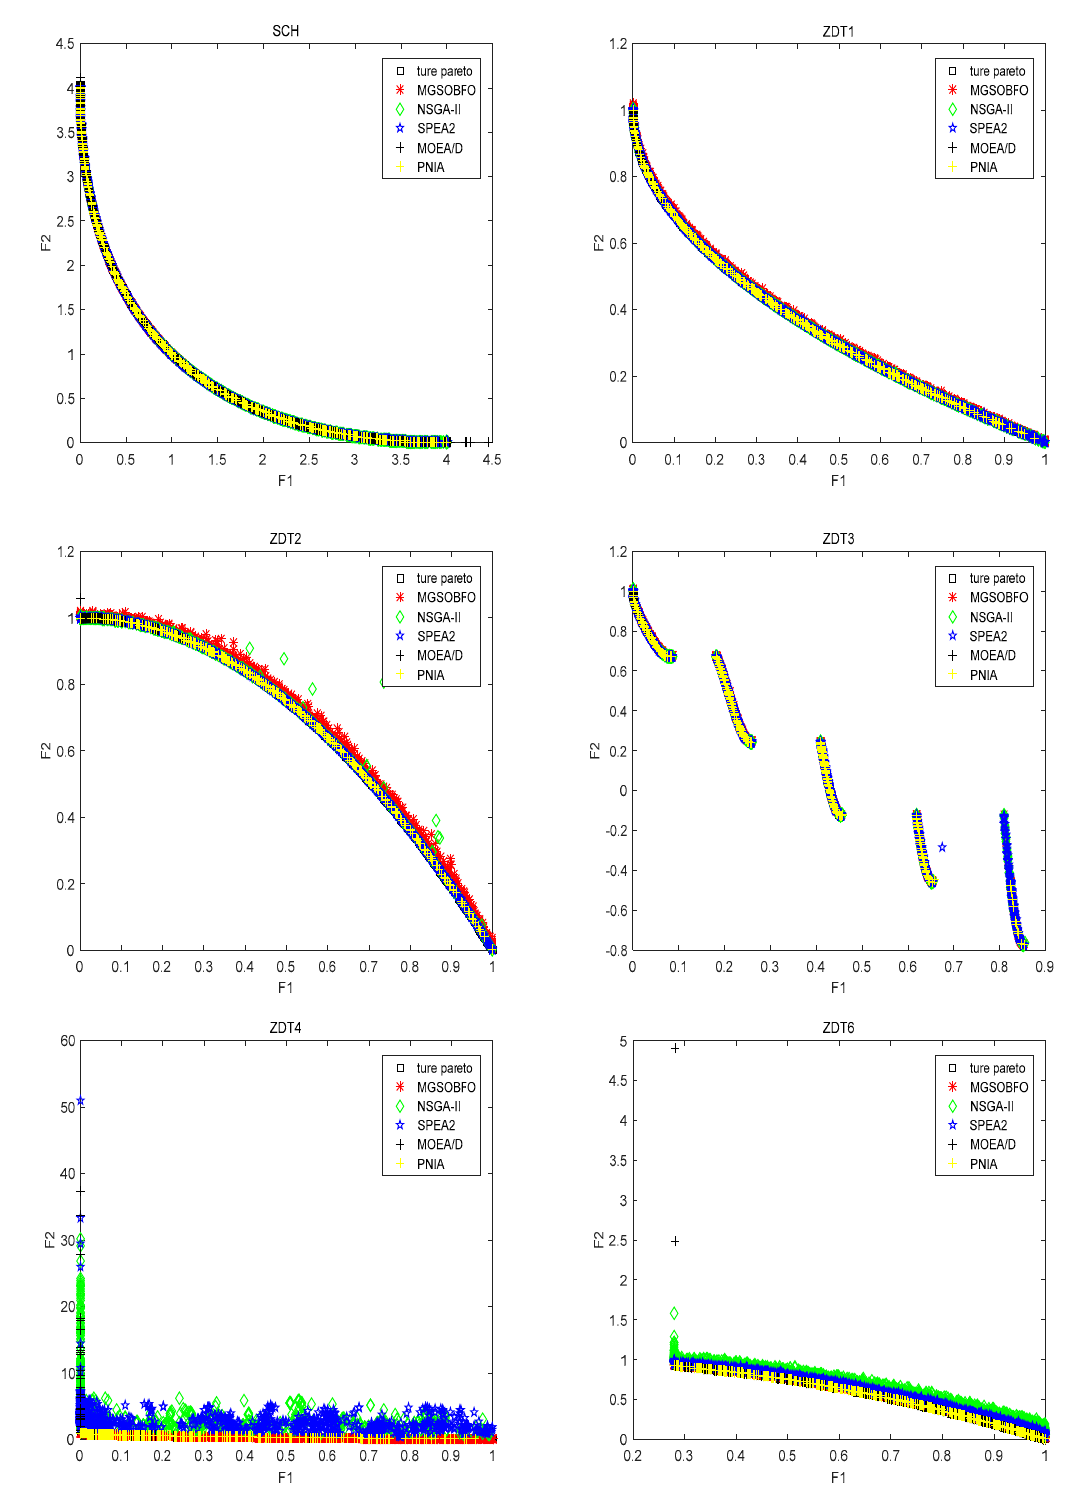
Figure 3. The results of dynamic performance comparison .